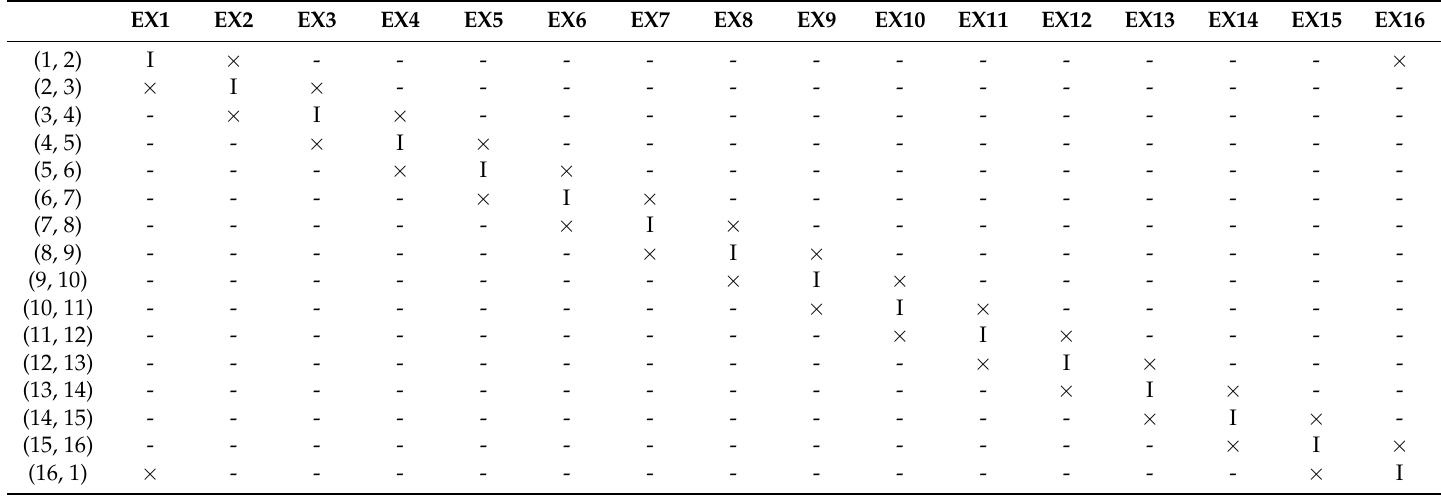
Table 1. The illustration of current injection pattern and voltage measurement pattern: 16 times of excitations (EX1 to EX16) for 16 pairs of electrode combinations ((1, 2), (2, 3) . . . . . . (16, 1)) of the neighboring method are applied. In the table, the current injection pattern marked with I , and voltage pattern marked with ‘-’ ( × means useless data, that will be removed